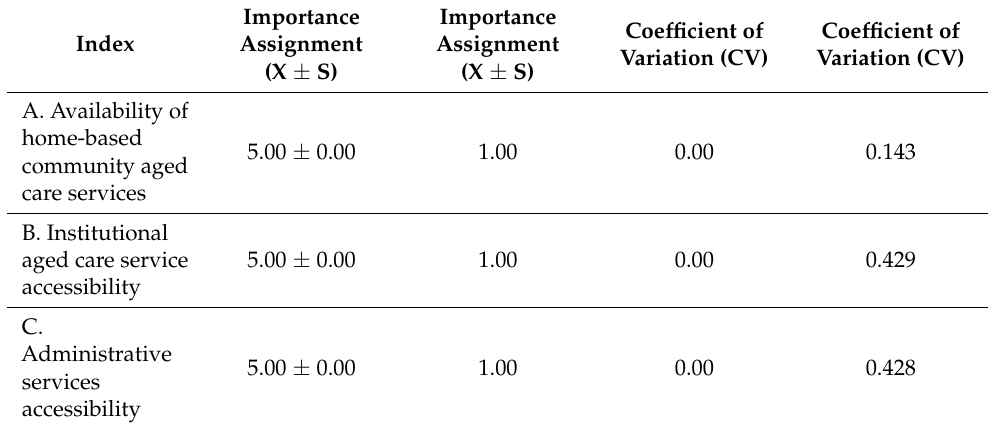
Table 5. Inquiry results of the first-level indicators of the indicator